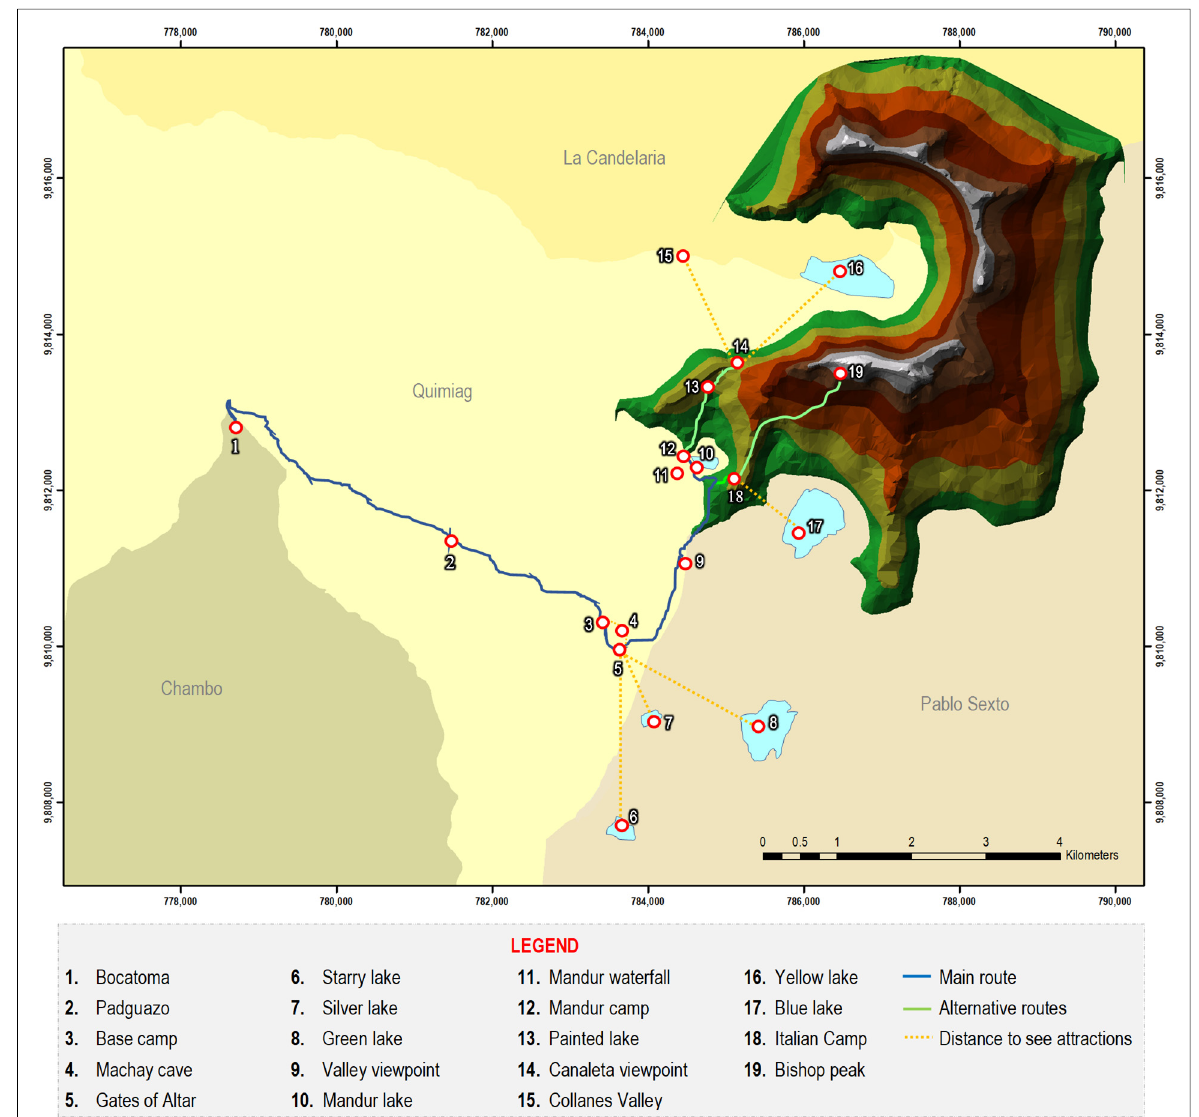
Figure 4. Tourist route on the Altar Volcano, Sangay National